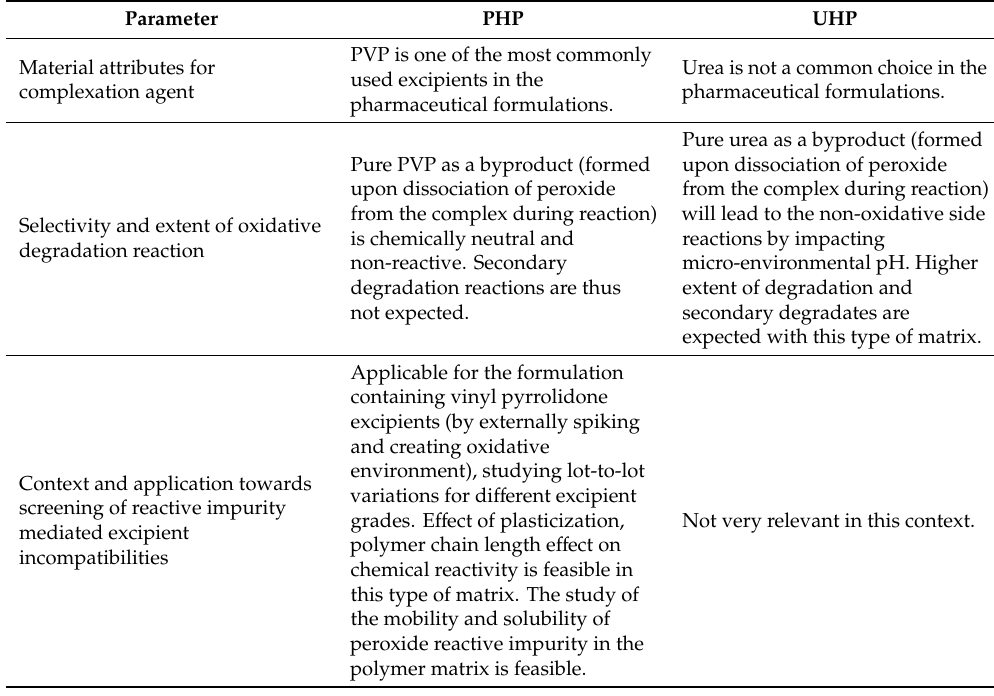
Figure 2. Overlays of partial IR spectra for ( a ) –O–H, ( b ) –C–O vibrational bonds. The dark line represents the unexposed UHP-VOR tablet sample (initial) and the dotted lines represents the UHP-VOR tablet compacts after open exposure to 40 ◦ C / 75% RH after 1 day (FD study). Table 2. Benefits of PHP over UHP as a solid-state